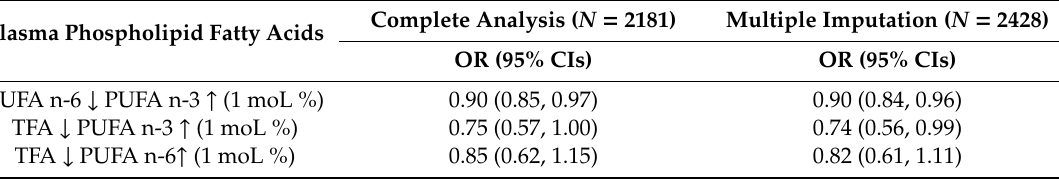
Table A6. Odds ratios a (95% CIs) of CHD associated with 1 moL % substitutions between plasma phospholipid fatty acid groups among participants with complete information versus using multiple imputation in the matched case-control